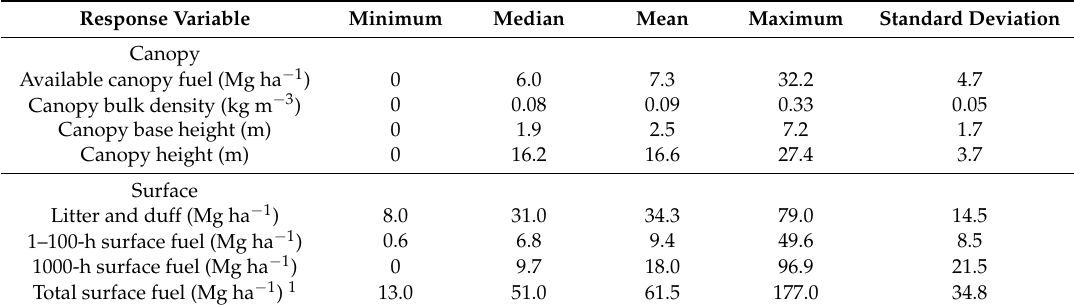
Table 3. Characteristics of canopy and surface fuels as measured on 119 field plots. Canopy and surface fuel variables were predicted from lidar and Landsat time series response variables using random forest models.